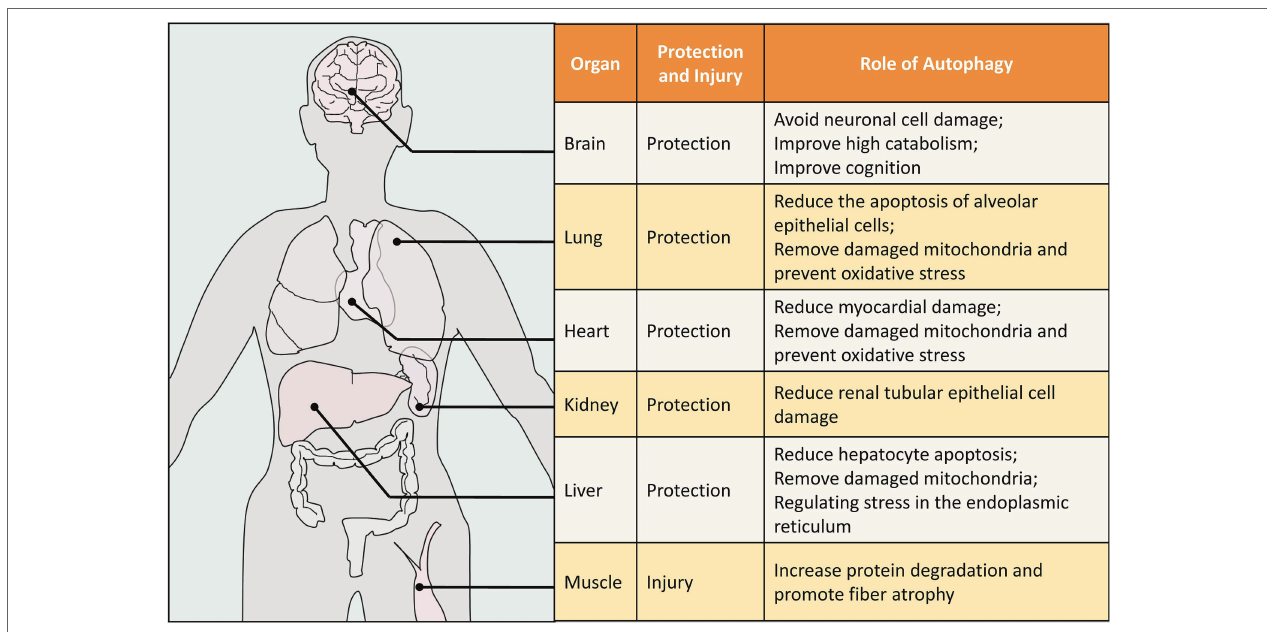
FIGURE 3 | The role of autophagy in different organs of sepsis. This figure is illustrated for humans, but the data is obtained from humans and other animals (mouse, rat, etc.). The protective or damaging effect of autophagy on organs in sepsis is our comprehensive judgment after literature